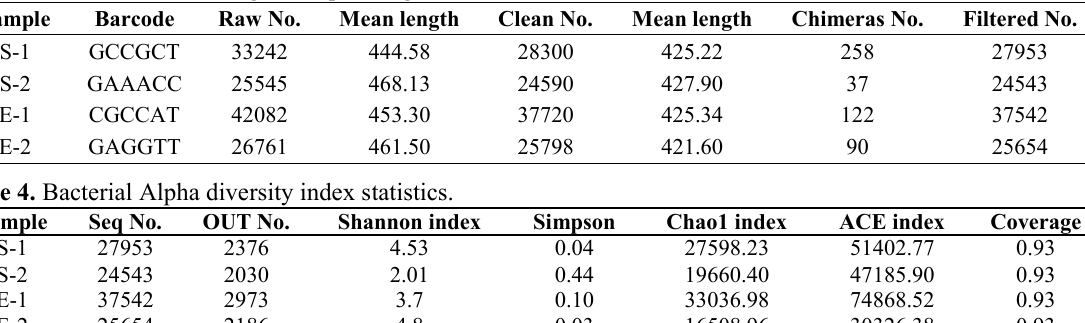
Fig. 3. The rectangles represent the samples, and the different samples are represented by different colors. OTU is marked as a pie chart, and the area size represents the size of the abundance. The different color patches in the pie chart represent the abundance of different samples on the OTU classification. Table 3. Bacterial 16S rDNA gene sequencing data statistics.